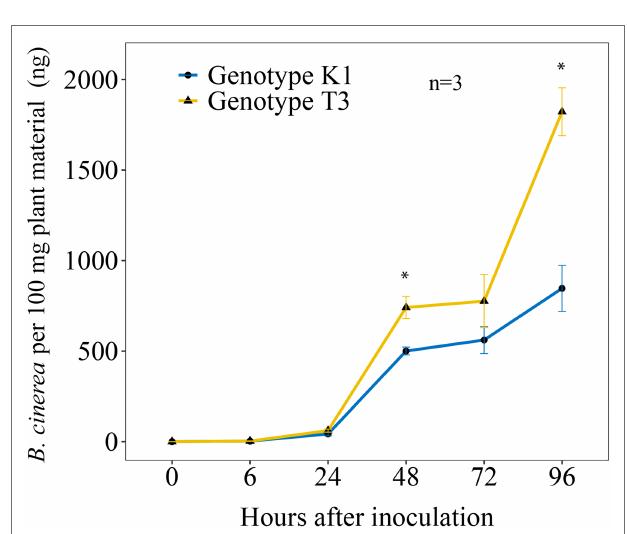
FIGURE 2 | Amount of B. cinerea B05.10 DNA per 100 mg leaves at different time points post inoculation (0, 6, 24, 48, 72 and 96 h post B. cinerea inoculation) in Kreuzkogel 1 (K1) and Tenno 3 (T3). The asterisk ‘ * ’ indicates significant differences among two genotypes by Wilcox test at p < 0.05. Values are represented as means of three replicates with standard error shown by vertical